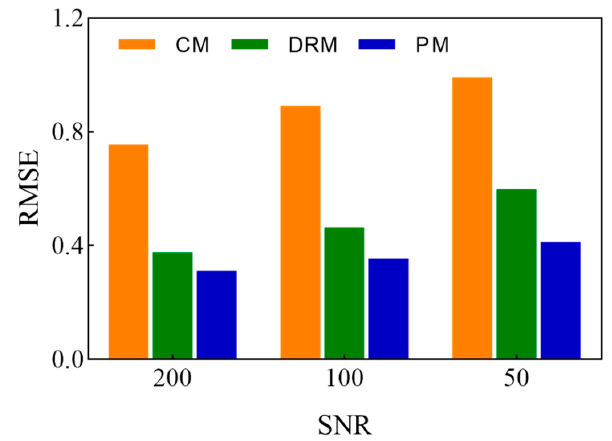
Figure 8. The RMSE of reconstructed conductivity images under noise conditions using the conventional method (CM), double regularization method (DRM), and proposed method (PM).